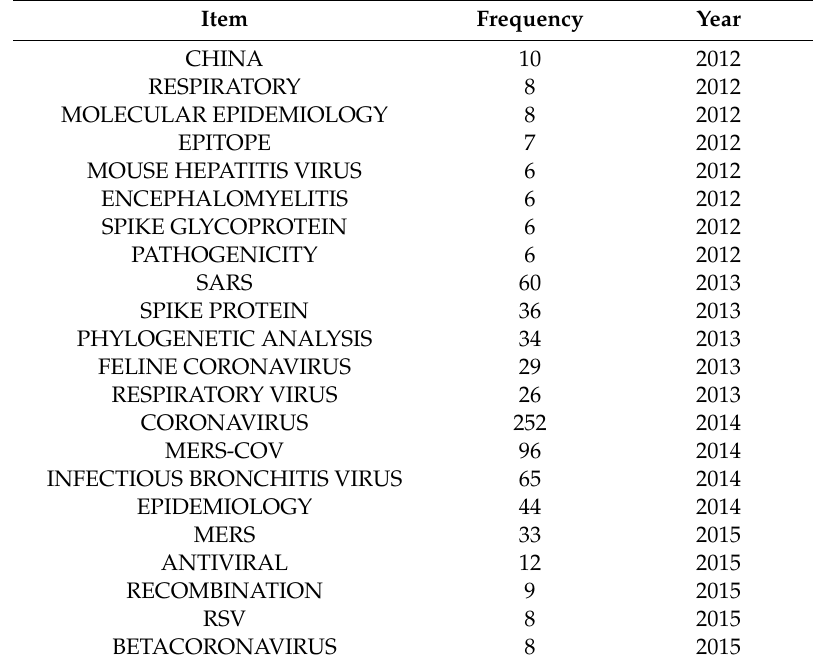
Table 7. Items and frequency of hot keywords during 2012–2018.